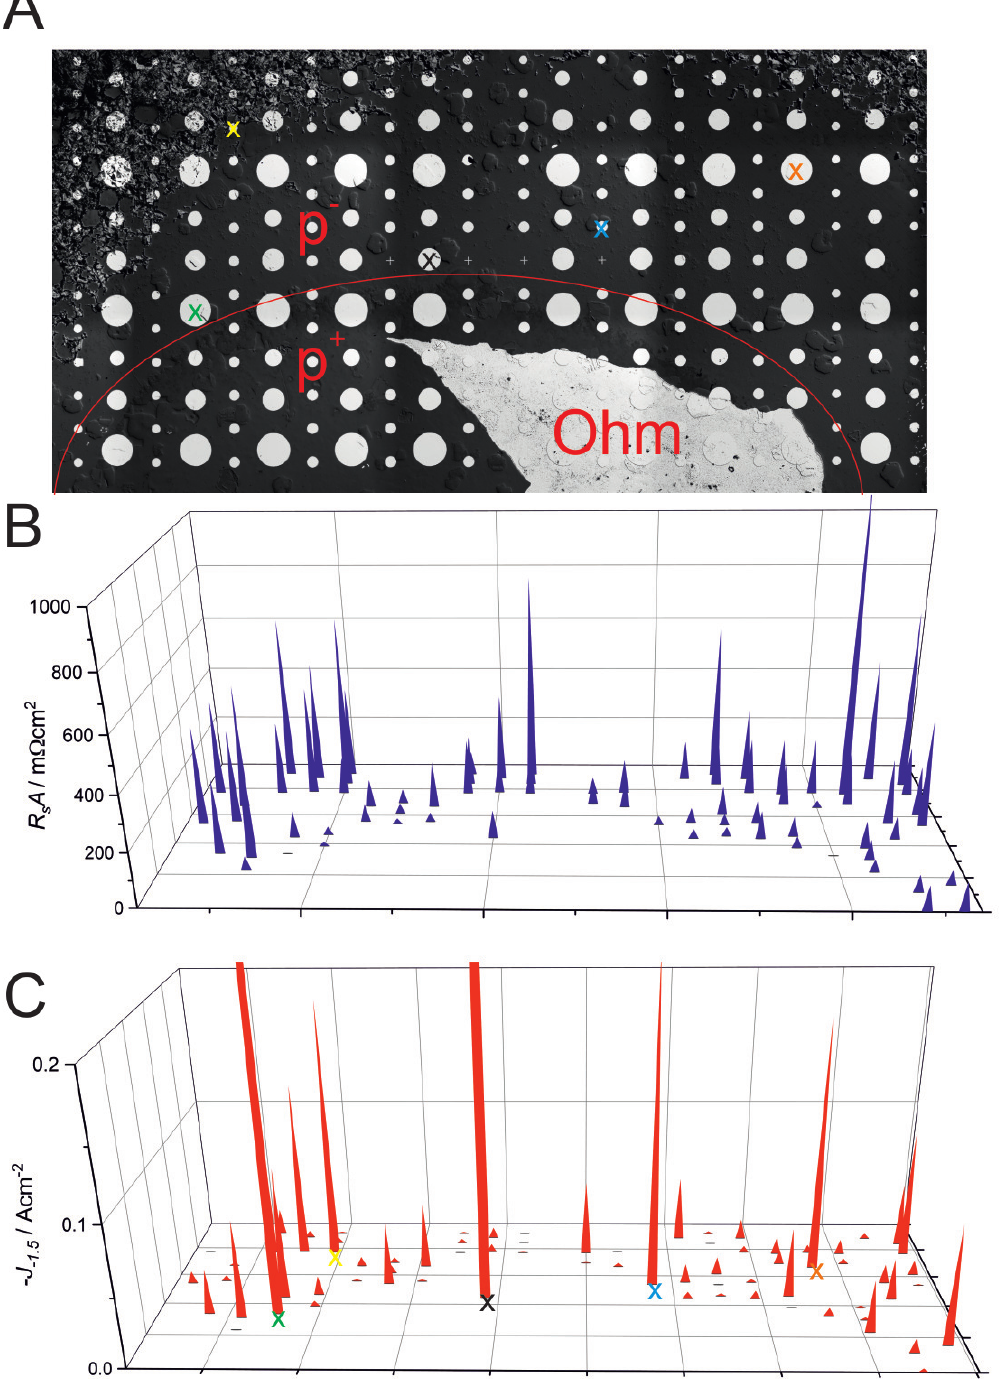
Figure 4. ( A ): Interference contrast micrograph of SE1 + SE2 sample III. The red line roughly marks the border at which the p + and p − regions are exposed after the polishing. The x markers correspond to the markers in panel C. ( B ): Mapping of R s A for all diodes measured on this sample with a clear thickness dependence; the arrangement on the chart exactly matches the arrangement of the diodes above. ( C ): Mapping of leakage current densities at − 1.5 V reverse voltage showing no systematic regional